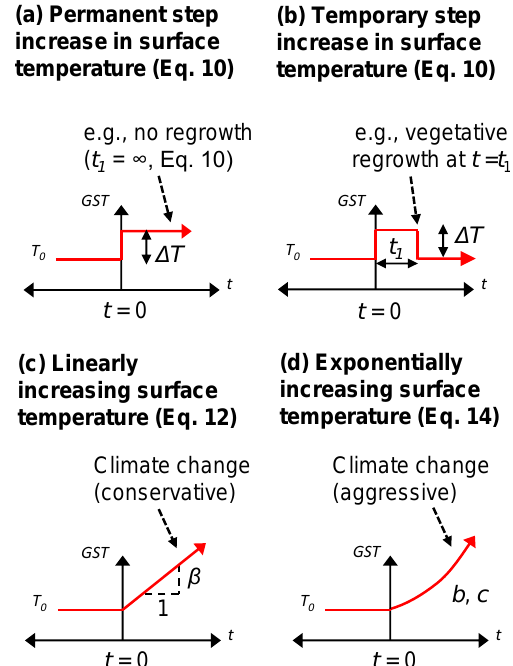
Figure 3. (a–b) The boundary conditions for ground surface- temperature (GST) disturbances due to land cover changes. Both (a) and (b) represent the boundary condition given in Eq. (10). The dif- ference between these is the duration of the period of warm surface temperatures ( t 1 =∞ in a ). (c–d) The boundary conditions for GST due to long-term climate change for conservative (linear; Eq. 12) and aggressive (exponential; Eq. 14) climate